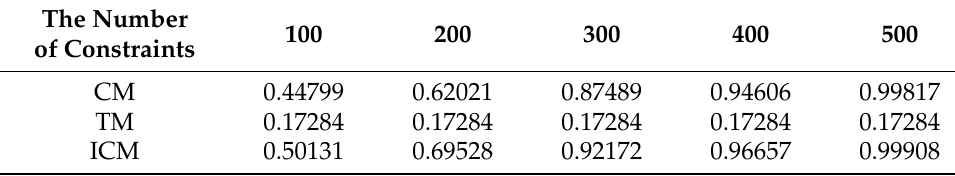
Table 2. Comparison of Adjusted Rand Index on dataset Ionosphere.